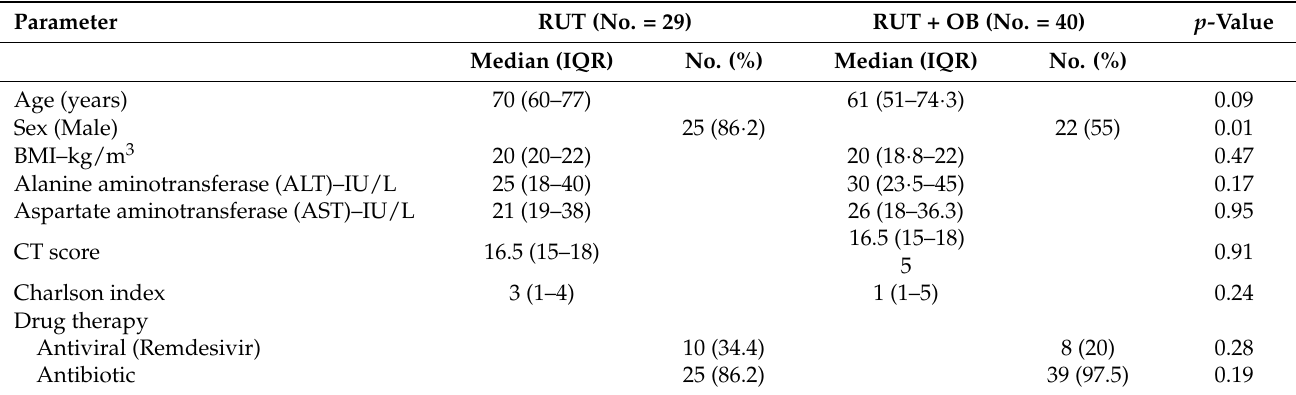
Table 1. Population stratified in two groups according to the therapy: RUT or RUT plus oral bacteriotherapy. IQR: interquartile range (25 ◦ –75 ◦